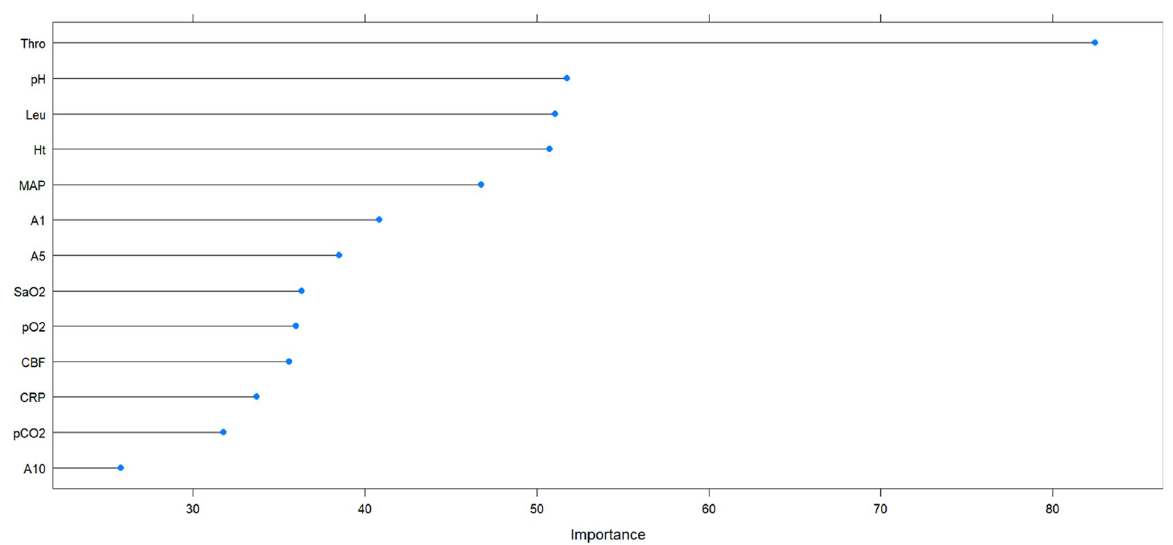
Fig 3. Variable importance plot for extremely preterm infants with 23 to 26 WG.